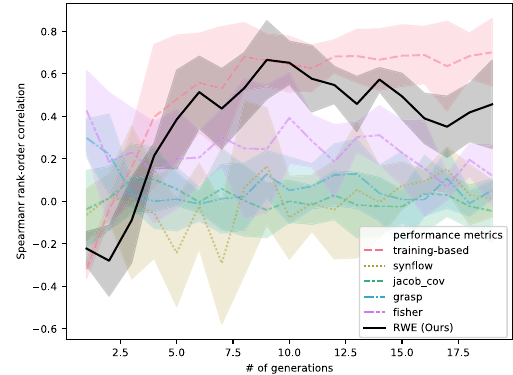
Fig. 3 The Spearman correlation coefficient for different performance metrics on NAS-Bench-301